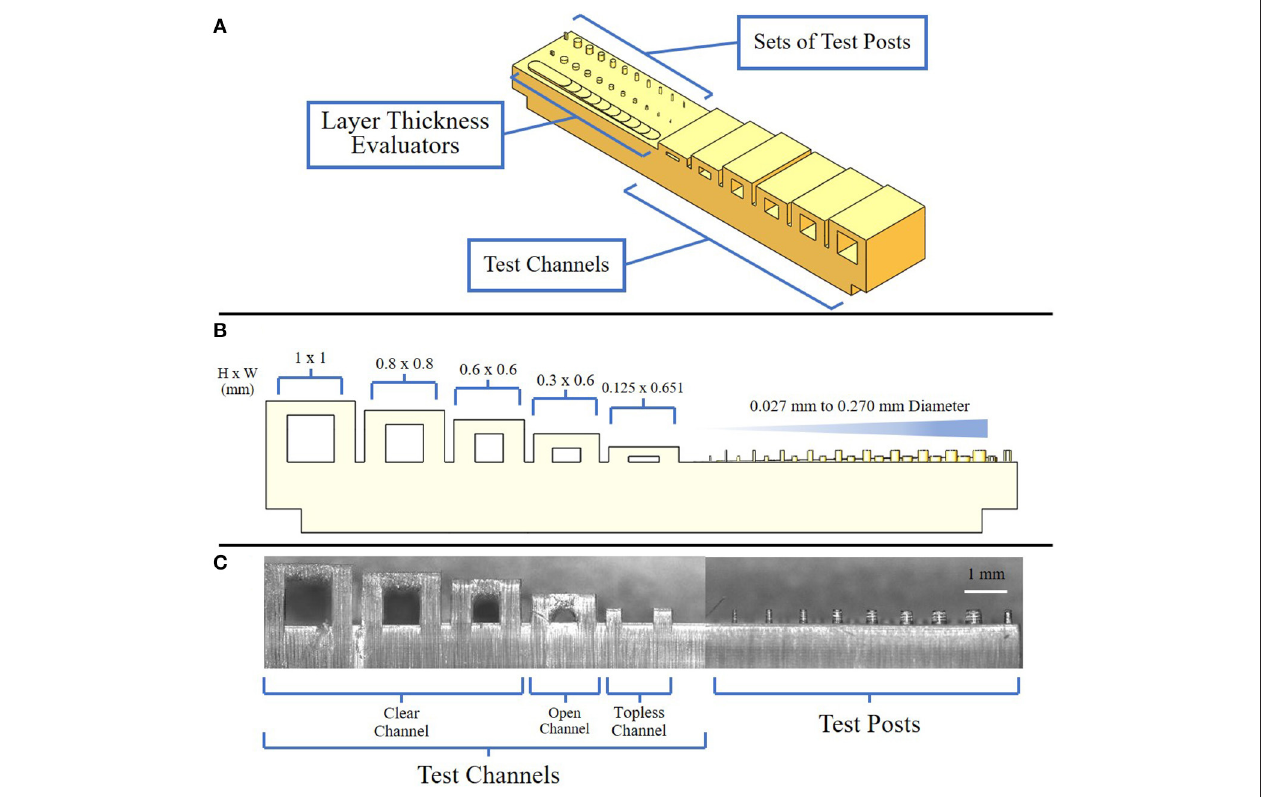
FIGURE 1 | Views of resolution testing device. (A) Isometric view of the resolution testing device composed of three major components: test channels, test posts, and layer thickness evaluators; (B) Side view of resolution testing device highlighting expected channel and post-dimensions; (C) Side view of a resolution testing device showing examples of clean, open, and topless